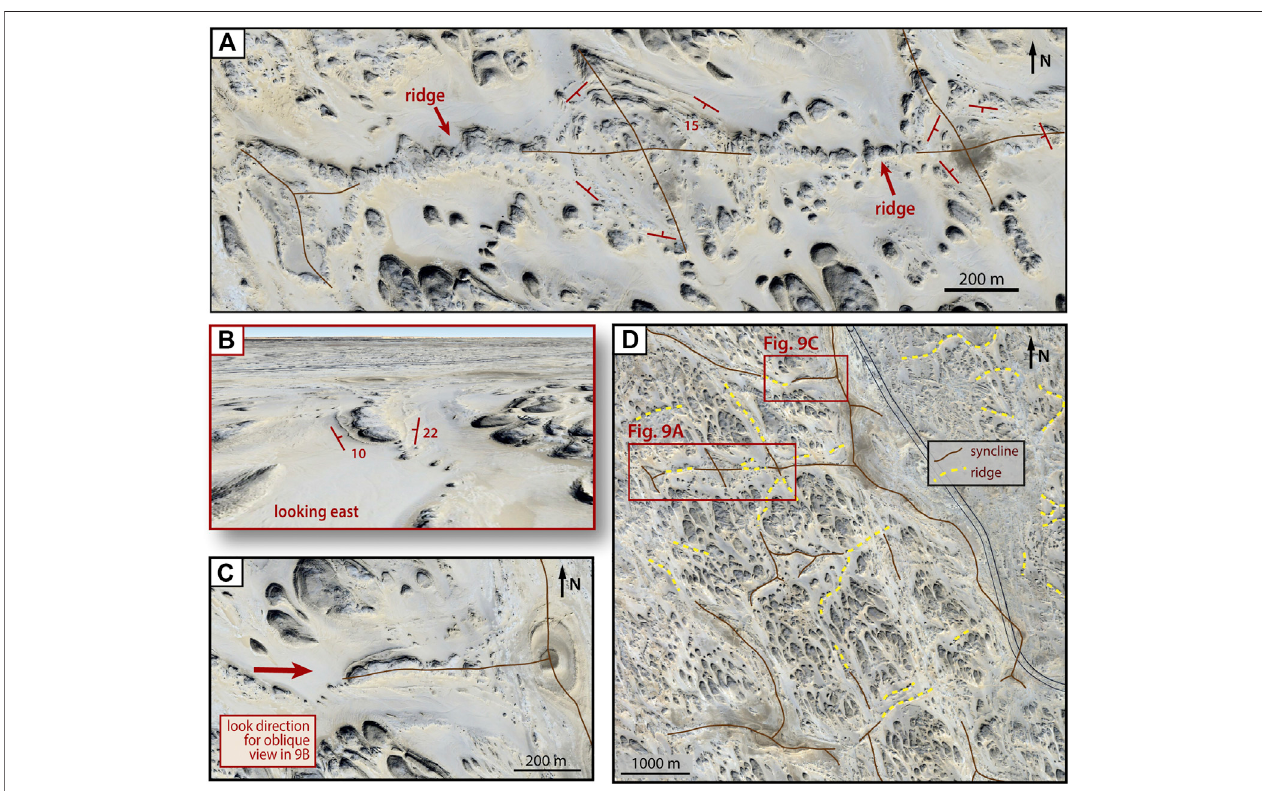
FIGURE 9 | Ridges and synclines occupy similar locations with respect to yardang fi elds in the ghost network terrain. Where a syncline dies out along trend, the trendtypicallycontinuesasanarrowridge. (A) Ridgeswithquasi-horizontalbeddingconnectthreebasinclosures. (B,C) Discontinuousnarrowridgeconnectseastward to broad ridge with shallow inward dips, which grades further east to a basin closure. (D) Combined with yardang fi elds, ridges and synclines de fi ne a subtle polygonal “ ghost ” network. Satellite imagery source: Google Earth. Coordinates for Google Earth images: A) 26.724487, 31.178602; C) 26.737089, 31.192582; D) 26.713315,